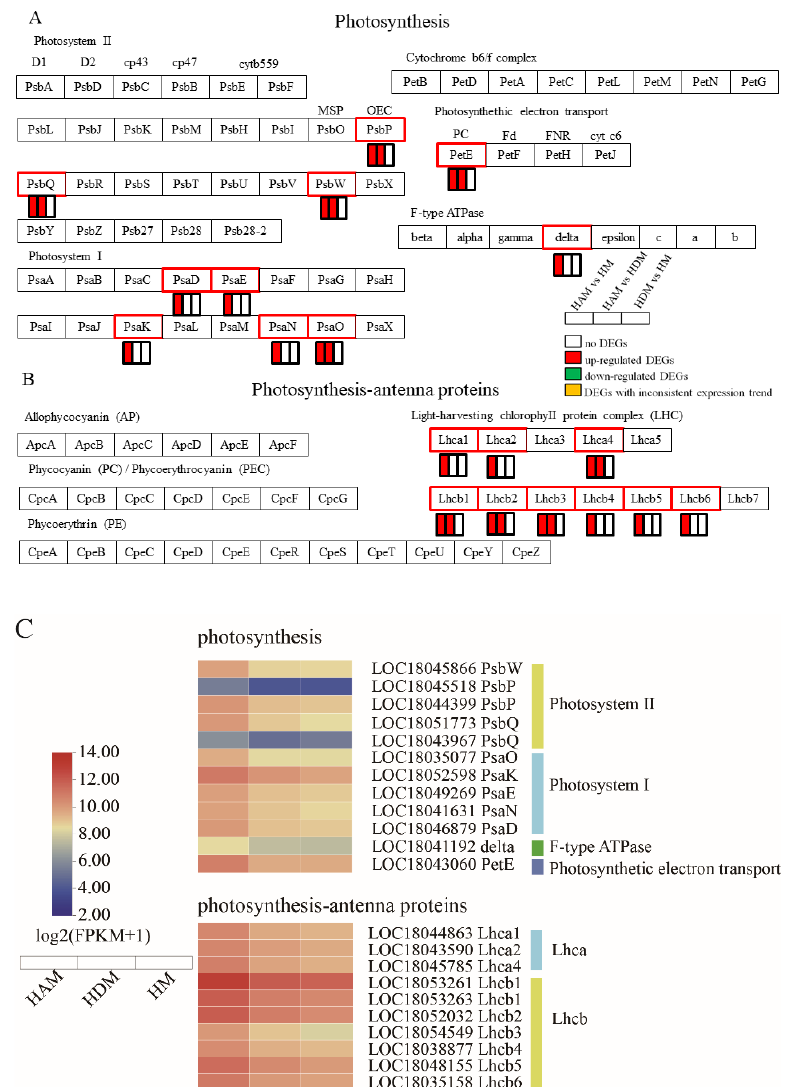
Figure 6. Interstocks induced changes in the expression profiles of photosynthesis-related genes in three comparisons. ( A ) Photosynthesis pathway genes, ( B ) photosynthesis–antenna proteins pathway genes, and ( C ) heat map of photosynthesis-related gene expression. The rectangles behind the gene, which were tagged with red, green, white and yellow color, represent the upregulated DEGs, downregulated DEGs, unchanged DEGs, and the DEGs with inconsistent expression trends,